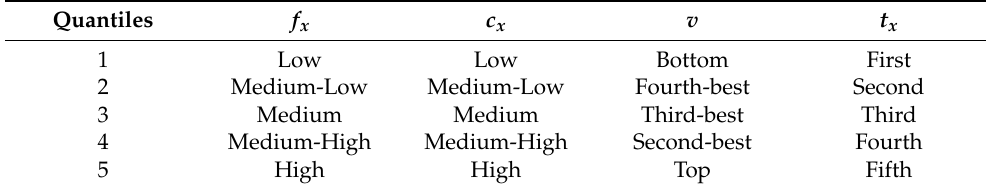
Table 1. Categorical values of the smart contracts execution main features. Quantiles f